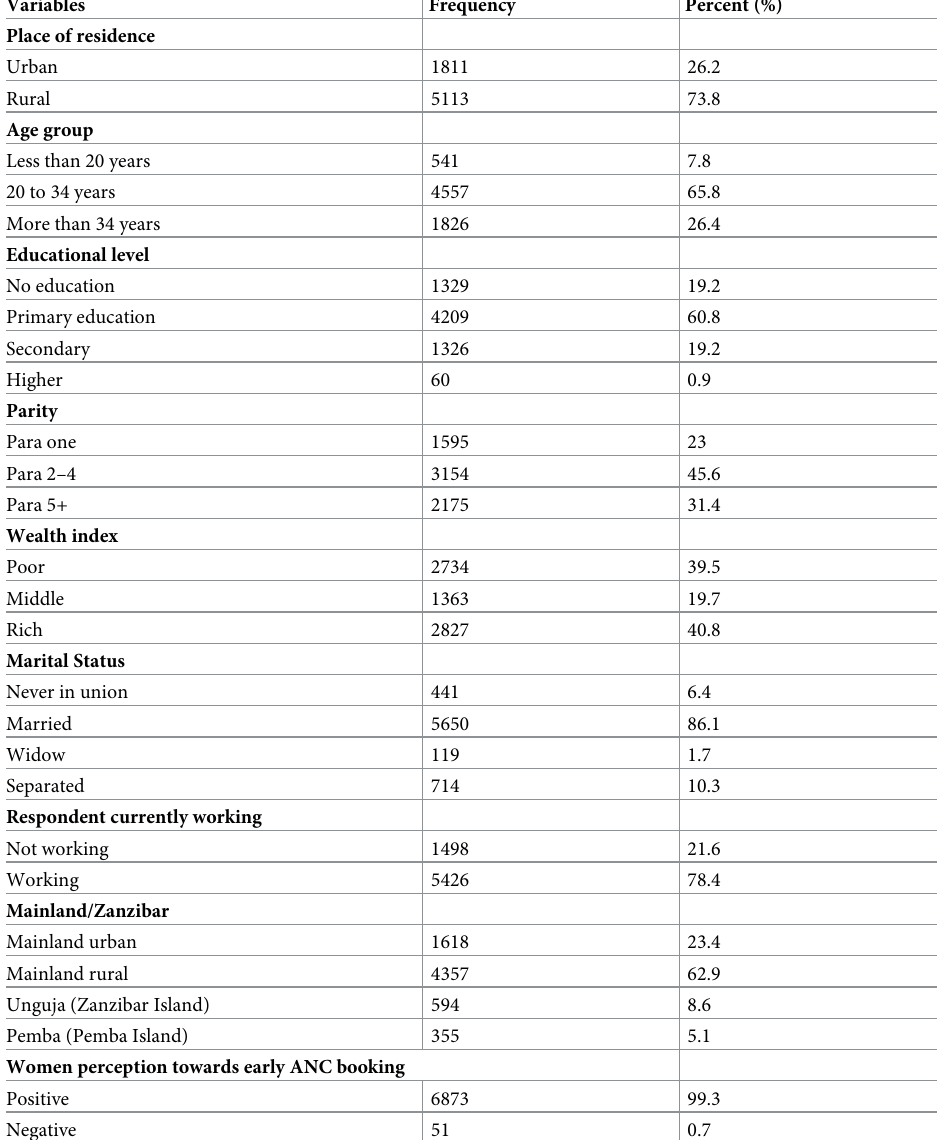
Table 1. Socio-demographic characteristics (n =